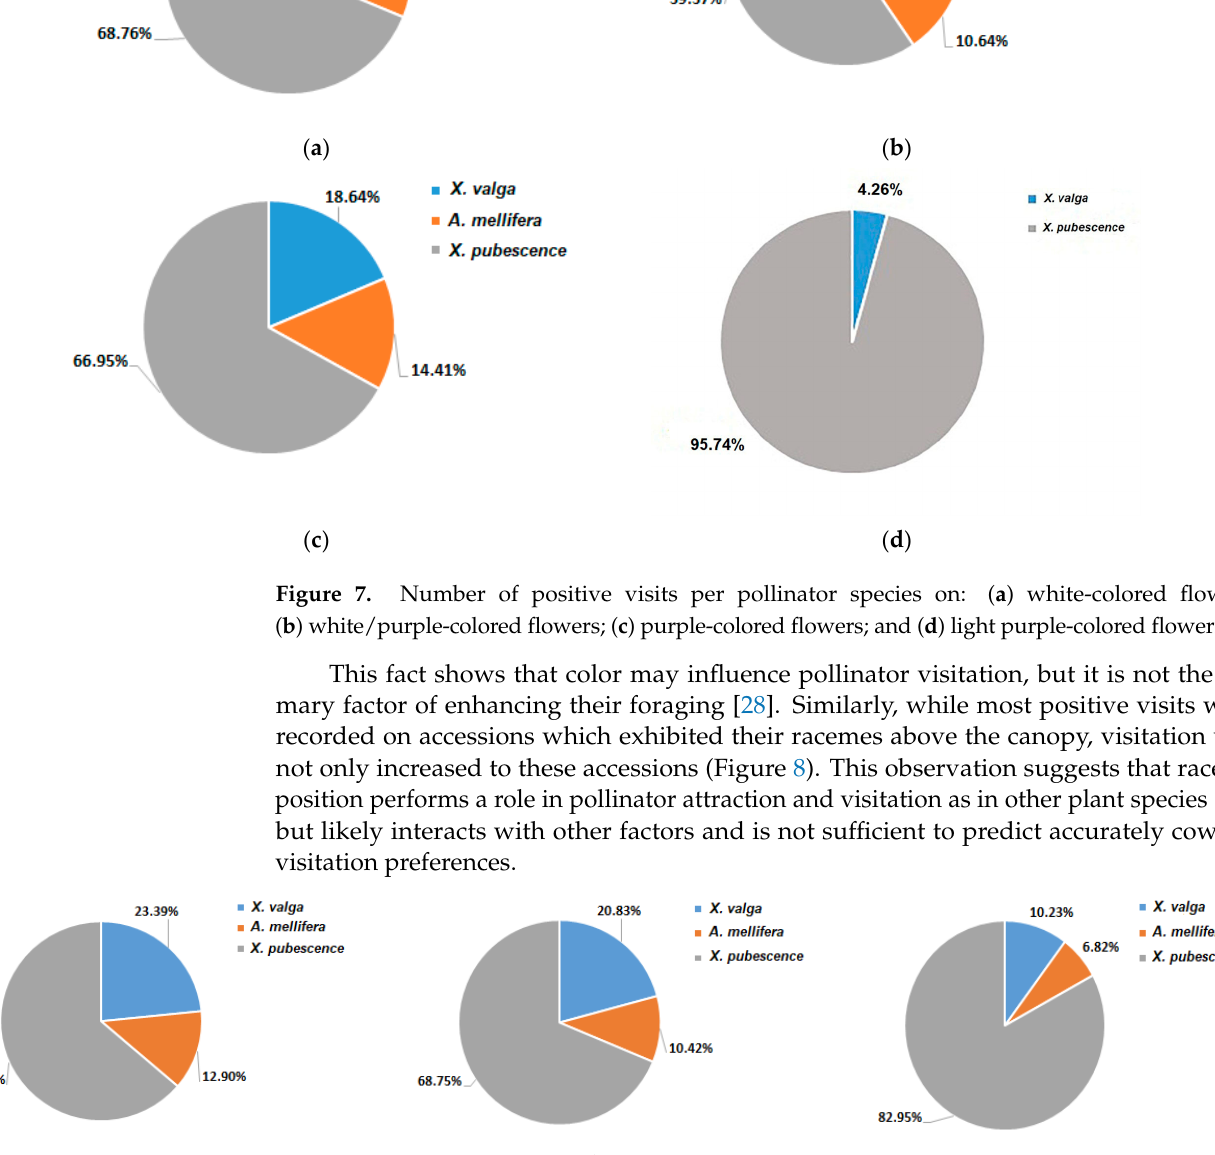
Figure 8. Number of positive visits on plants with racemes: ( a ) mostly above the canopy; ( b ) on the upper canopy surface; and ( c ) throughout canopy. Significant correlation of foraging behavior with the hours that the flowers remained open during the day (h) (DFDUR) were recorded only on two observation days, and that was not of a linear relation. Flowering beginning and closure time during a day varied